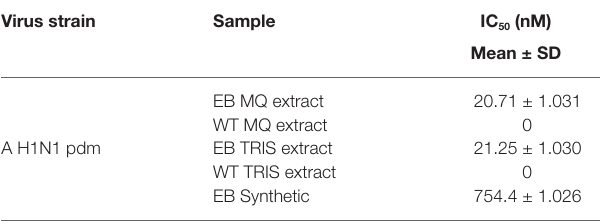
TABLE 2 | Inhibition of viral replication with EB